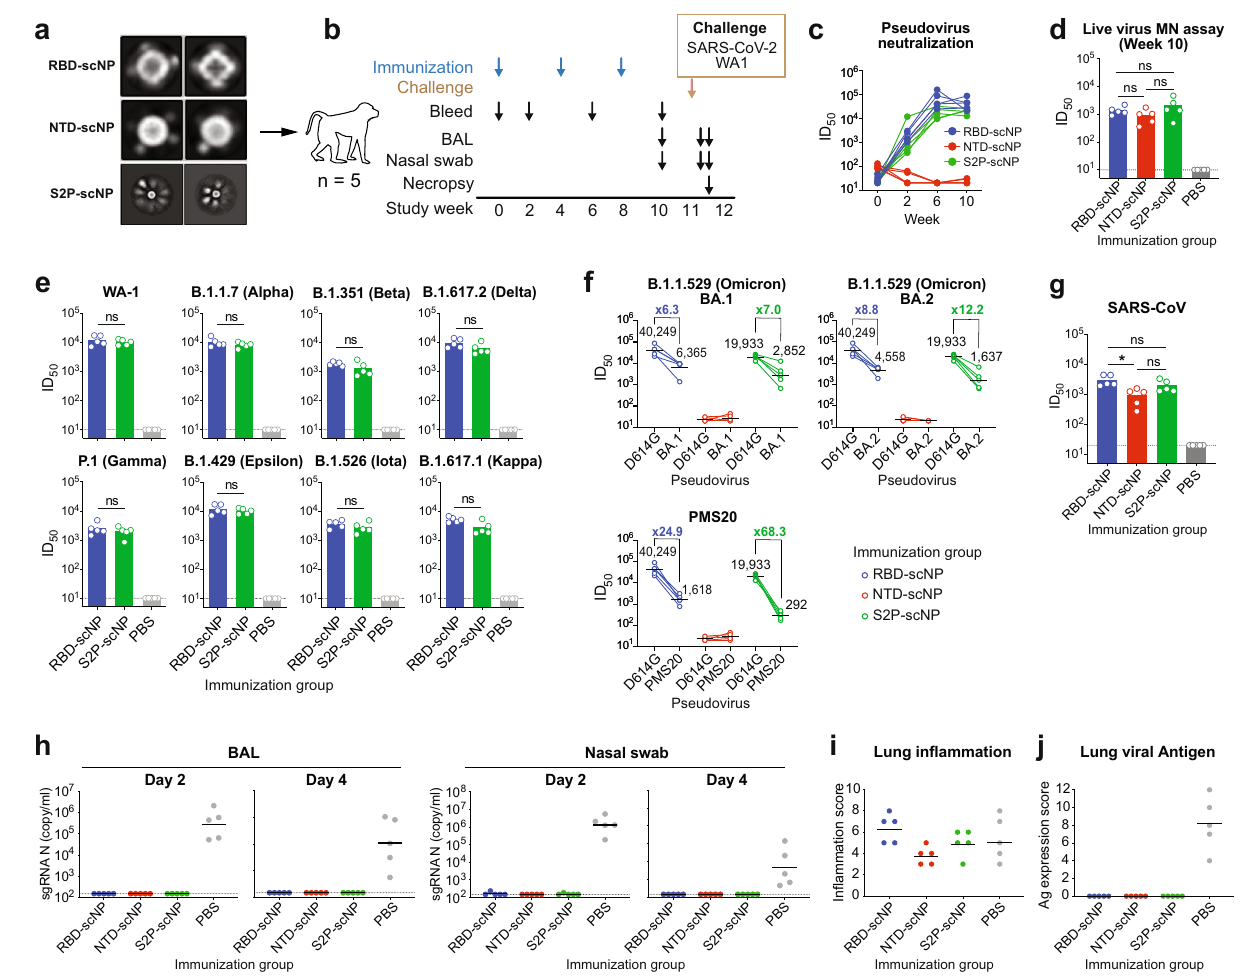
Fig. 2 | Neutralizing antibodies and in vivo protection induced by RBD-scNP, NTD-scNPand S2P-scNPvaccines.a Negative-stain electron microscopy 2D class averaging of RBD-scNP, NTD-scNP, and S2P-scNP. The 2D class averaging of 14,300RBD-scNPparticles,10,800 NTD-scNP particlesor1034 S2P-scNPparticles were generated using RELION. The size of each box: RBD-scNP and NTD-scNP, 257Å; S2P-scNP, 1029 Å. b Schematic of the three-dose regimen. Cynomolgus macaques ( n =5 per group) were immunized 3 times with RBD-scNP, NTD-scNP, or S2P-scNP adjuvanted with 3M-052-Alum. Monkeys were then challenged with SARS-CoV-2 WA-1, sampled for blood, BAL and nasal swabs, and necropsied for pathologic analysis. c Neutralization titers of plasma antibodies (week 0, 2, 6 and 10) against pseudotyped SARS-CoV-2 D614G strain in 293T/ACE2.MF cells. d Neutralization titers of plasma antibodies (week 10) against live SARS-CoV-2 WA-1 virus in Vero-E6 cells in microneutralization (MN) assay. Each dot indicates one monkey ( n =5 per group) and bars indicate geometric mean values of each group. Adjusted p -values: ns not signi fi cant, * p <0.05, two-sided Wilcoxon rank